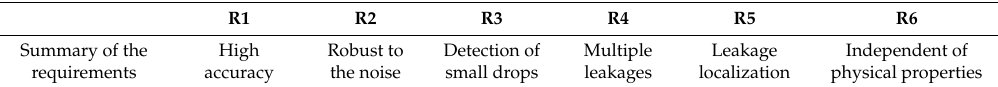
Table 1. Summary of the